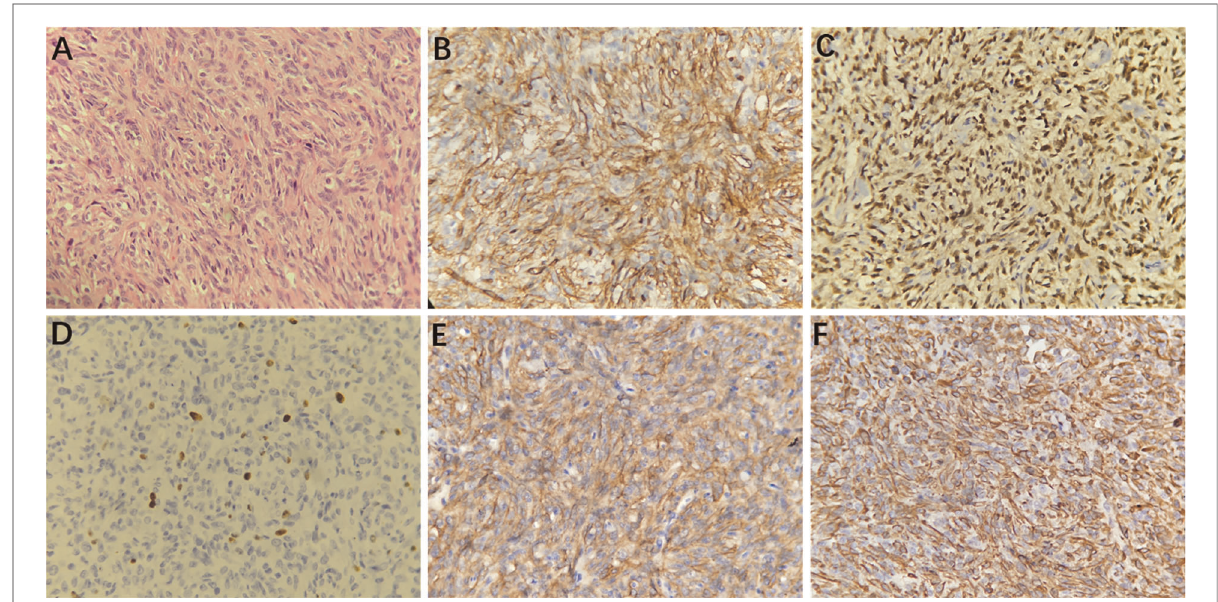
FIGURE 5 Microscopically, the tumor cells were arranged densely with fi ssure-like vessels, and staghorn-like vessel lacunes were observed; the nuclei were ovoid or long-spindle-shaped with inconspicuous nucleoli ( A , hematoxylin and eosin [H&E] staining, 400× magni fi cation). Immunohistochemistry staining at 400× magni fi cation showed that the tumor cells were positive for CD34 ( B ), STAT6 ( C ), Ki67 (8%, D ), CD99 ( E ), and Vimentin ( F